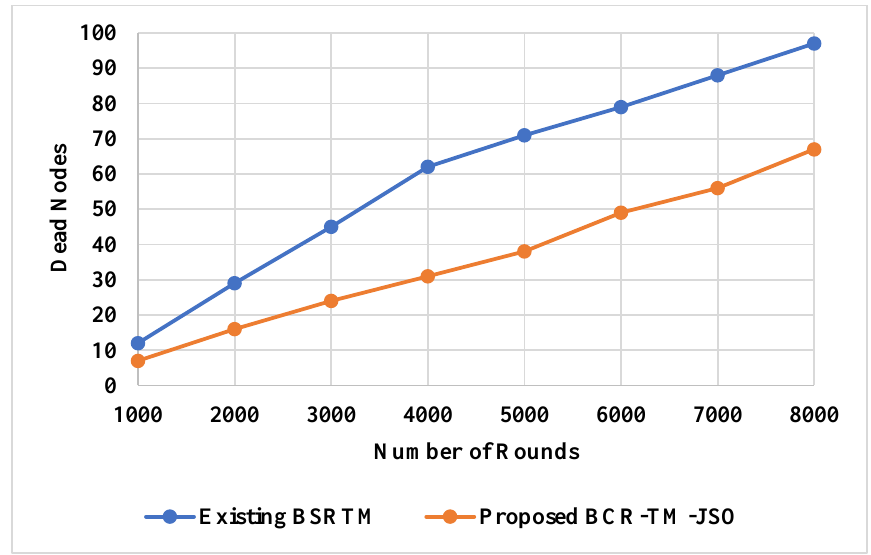
Figure 8. Performance of lifetime in terms of dead nodes with existing BSRTM [21].